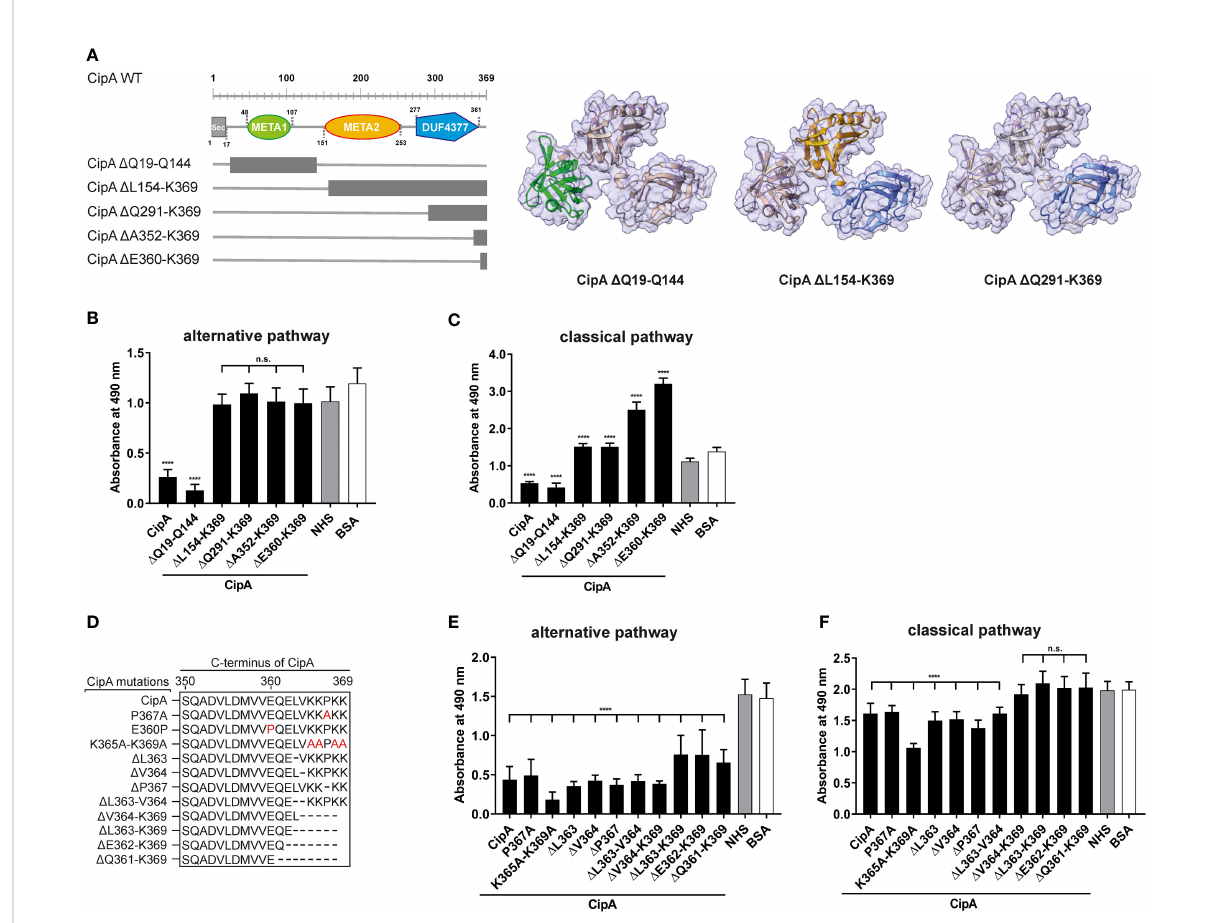
FIGURE 1 Assessment of the inhibitory capacity of CipA and CipA variants on activation of the AP and CP. Schematic representation of N- and C-terminal deletion CipA variants and structure predictions generated by using AlphaFold2.0 (A) . Deletions are as follows: CipA D Q19-Q144 removes the whole META1 domain (green), CipA D L154-K369 removes the META2 (orange) and DUF4377 (blue) domains, while the CipA D Q291-K369 deletion removes most of the DUF4377 domain. Schematic representation of CipA variants carrying single and multiple deletions or substitutions (in red letters) (D) . WiELISA was performed to assess the inhibitory capacity of CipA deletion variants on the AP (B, E) and CP (C , F) . NHS pre-incubated with the puri fi ed CipA proteins or BSA (500 nM for AP and 2.5 µM for the CP) were added to microtiter plates immobilized with LPS (AP) or IgM (CP). Formation of the MAC was detected by using a monoclonal anti-C5b-9 antibody. Data represent means and standard deviation of at least three different experiments, each conducted in triplicate. ****, p ≤ 0.0001, n.s., no statistical signi fi cance, one-way ANOVA with post-hoc Bonferroni multiple comparison test (con fi dence interval =